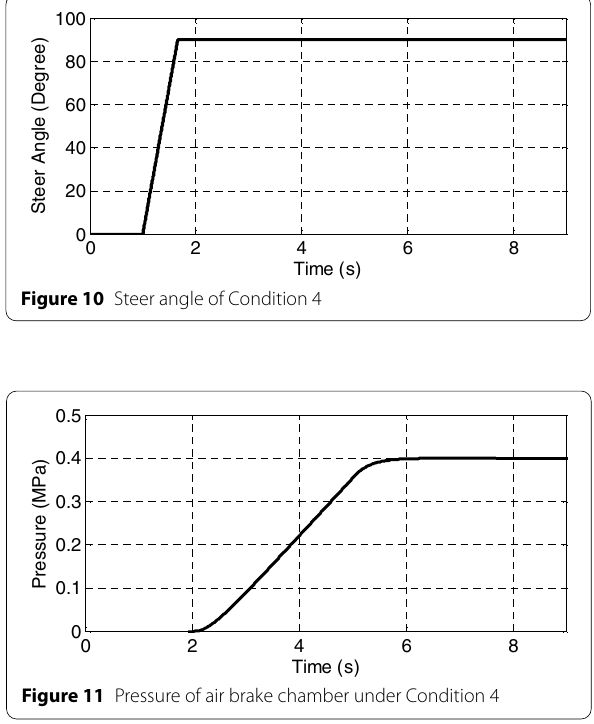
right tire, (c) shows the forces of the third left tire, (d) represents the forces of the third right tire, (e) shows the forces of the second right tire, (f) indicates the forces of the first right tire, (g) shows the forces of the first left tire,